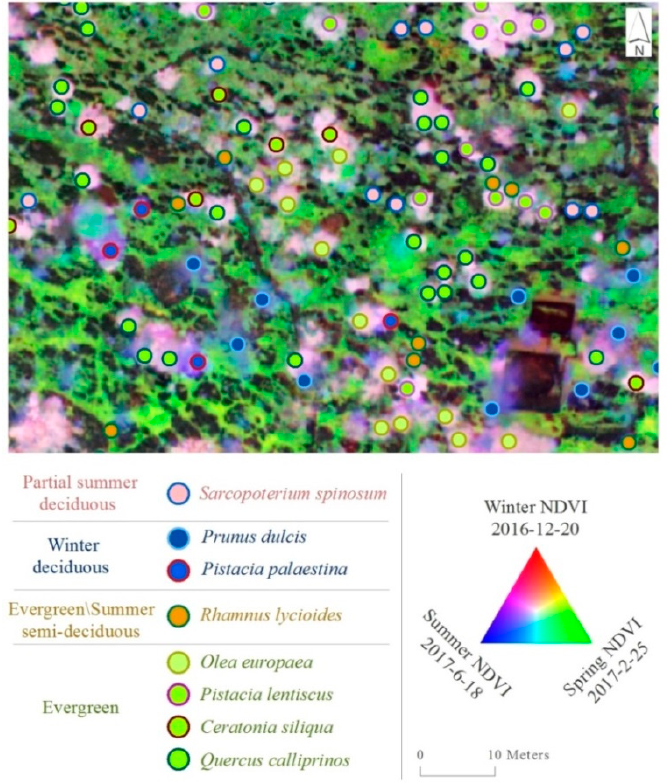
Figure 11. Annual phenology of species in the Mata site (M), as reflected in a false-color composite of the UAV imagery. Winter NDVI (20 December 2016) appears in red shades, spring NDVI (25 February 2017) appears in green shades, and summer NDVI (18 June 2017) appears in blue shades.